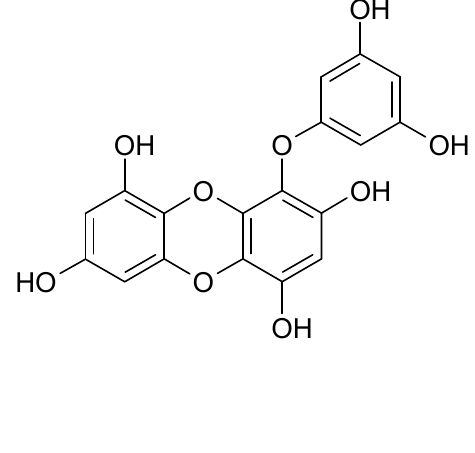
Figure 1. Chemical structure of eckol isolated from Ecklonia stolonifera